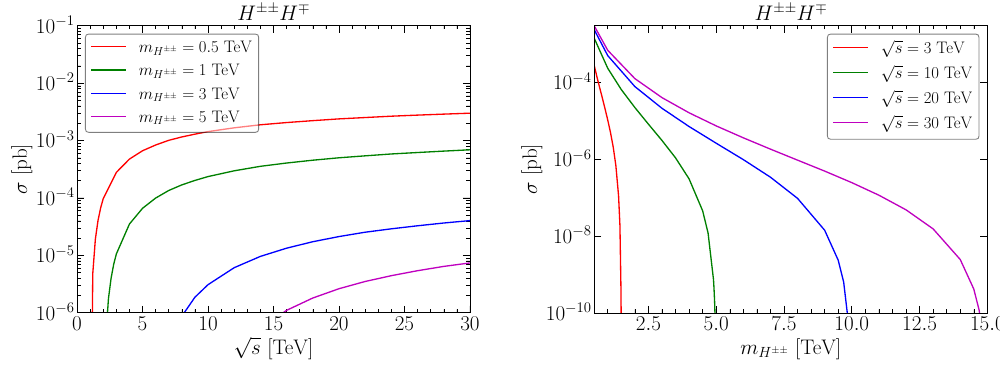
Figure 9 . Cross sections of H ±± H ∓ associated production as a function of the collider energy √ s (left) and heavy Higgs masses m processes. The charged Higgs masses and the c.m. energies are assumed to be the same values as those in figure